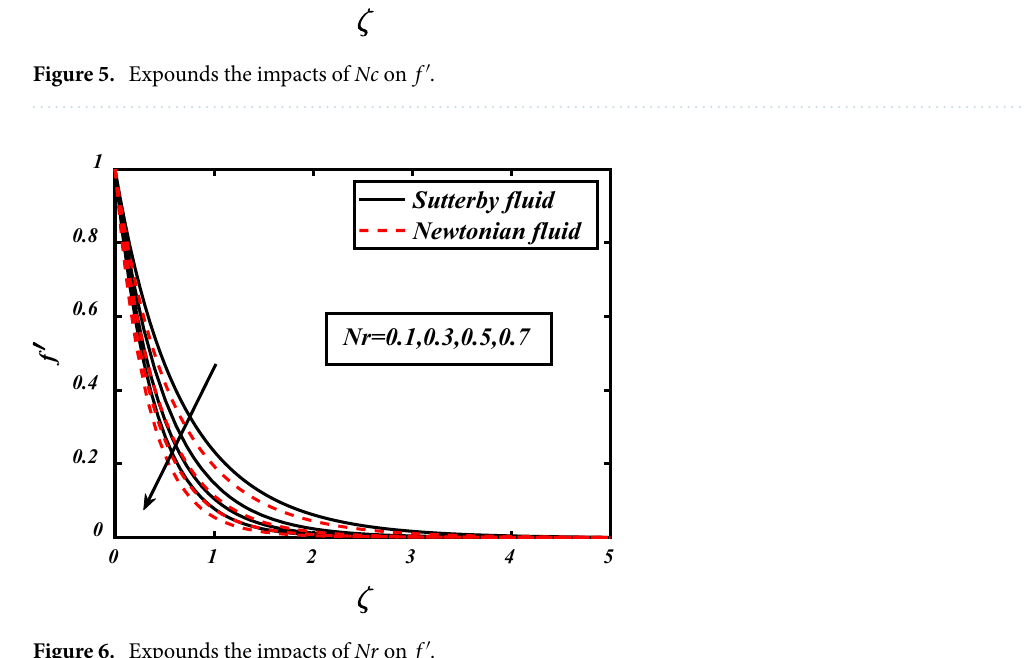
Figure 6. Expounds the impacts of Nr on f ′ .